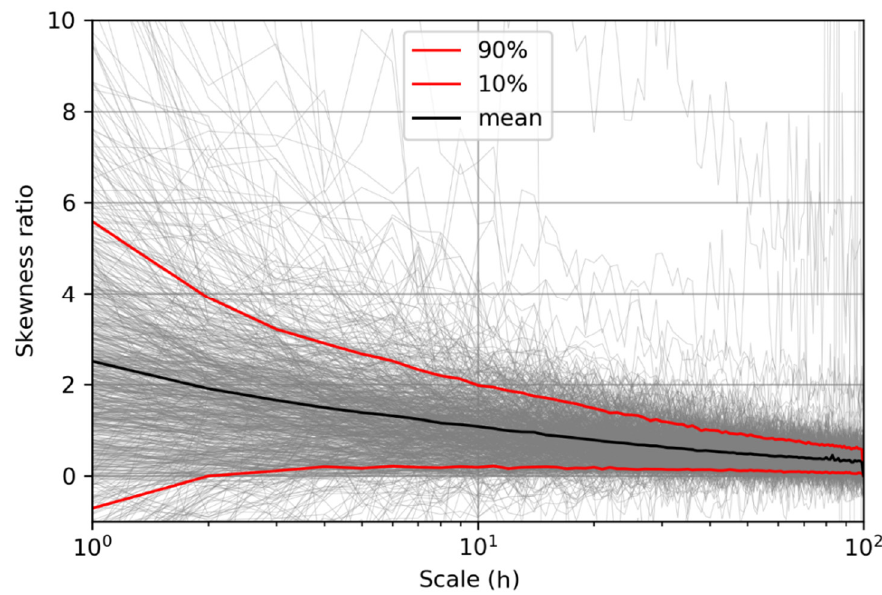
Figure 2. Irreversibility index for the 762 stations around the USA.